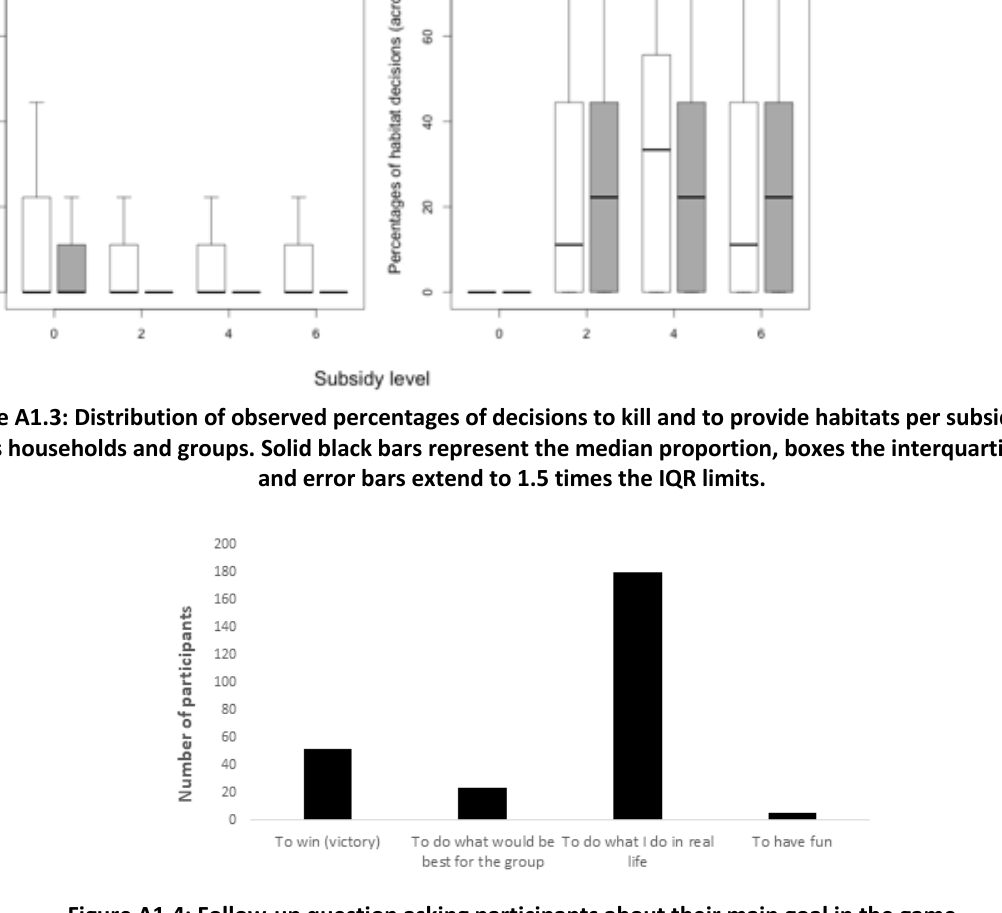
Figure A1.4: Follow-up question asking participants about their main goal in the game Table A1.1a: Factor loading of the interpersonal community trust